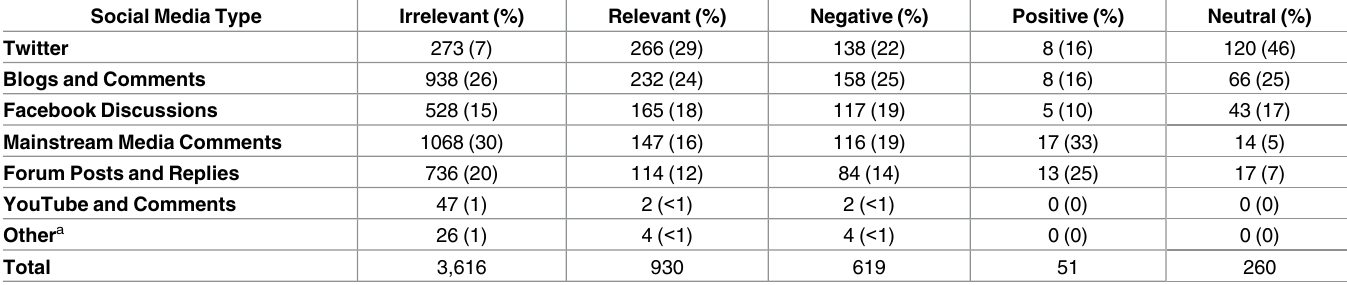
Table 1. Distribution of relevant and irrelevant posts by social media type. Relevant posts further categorized accordingnegative,positive,and neutral sentiment. Posts captured from social media referencingChicagoteachers’ strike from September 8–21, 2012 (two days before to three days after